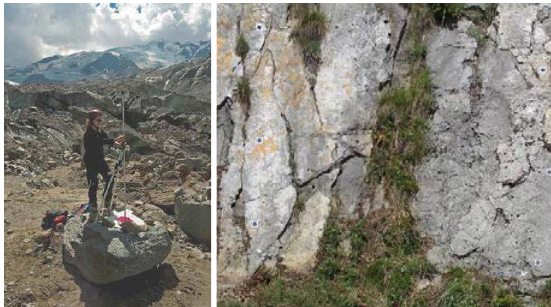
Figure 4. GCP measurement: on the left (a) an example of a marker put on a rock for UAV photogrammetry; on the right (b) some markers put on a rock face for terrestrial